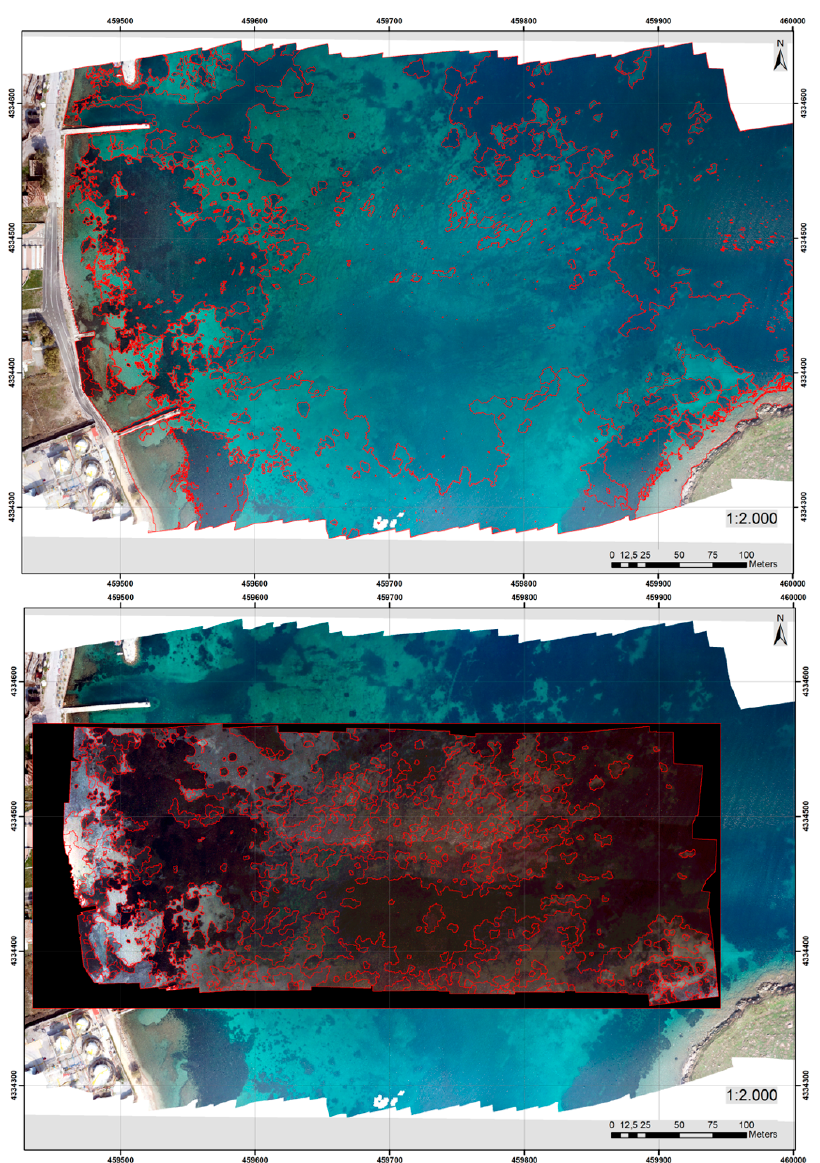
Figure 6. Results of the segmentation process for scenarios 1 and 2. The segments depicted are the result of the unification process to form one segment per category: true-color RGB orthomosaic (top) and multispectral orthomosaic (bottom).